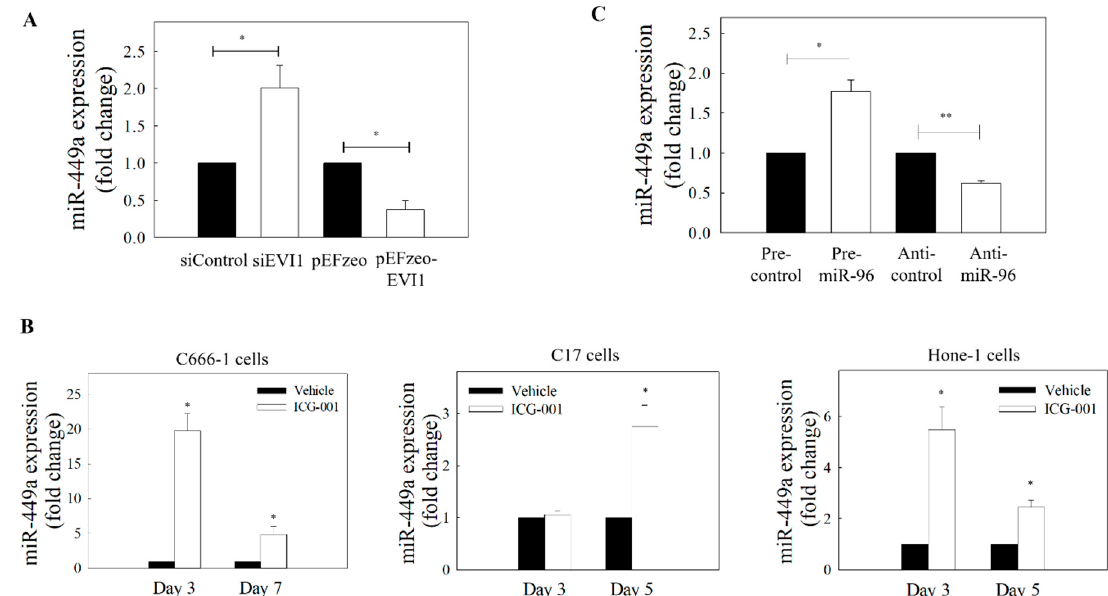
Figure 5. EVI1 downregulates miR-449a in NPC cells. ( A ) Expression of miR-449a in C666-1 cells transfected with EVI1 siRNA or pEFzeo-EVI1 plasmid. ( B ) Expression levels of miR-449a in ICG-001-treated EBV-positive (C666-1 and C17) and EBV–negative (Hone-1) NPC cells. ( C ) Effect of miR-96 on the expression of miR-449a in C666-1 cells. At least three individual experiments were performed. * p < 0.05, ** p < 0.01 compared with the corresponding control.